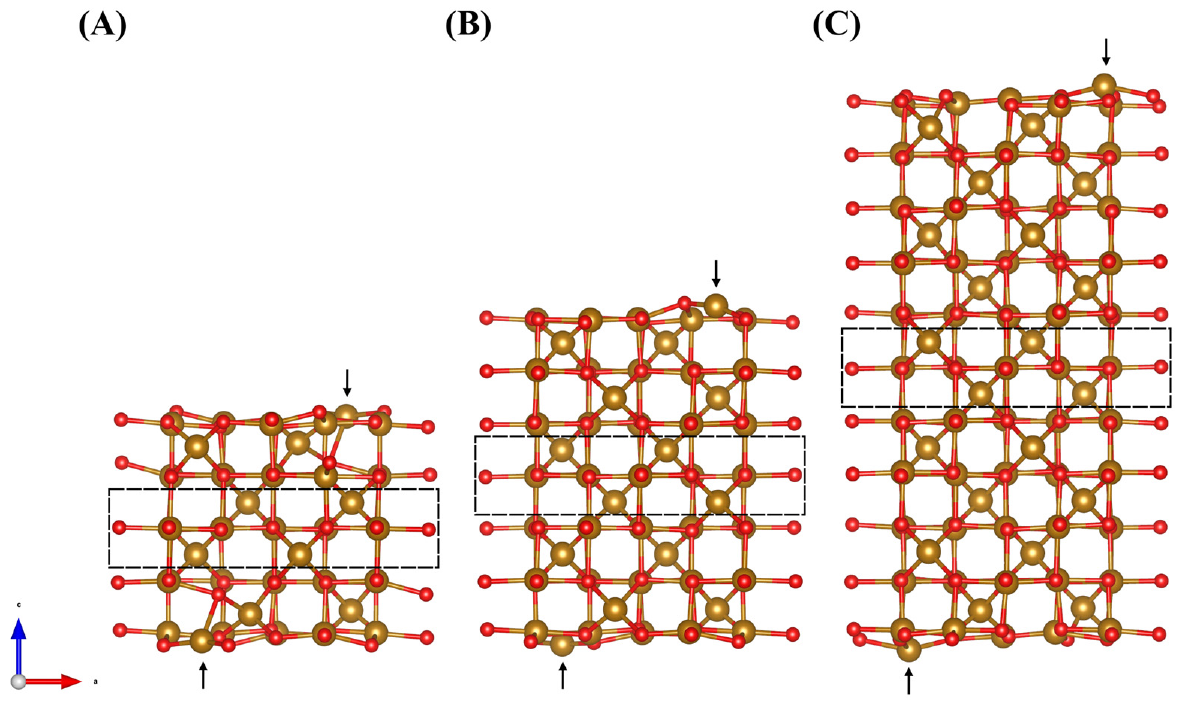
Figure 7. The 9-layer ( A ), 15-layer ( B ), and 23-layer ( C ) relaxed surfaces with Hubbard U correction. Dashed rectangle indicates region where atoms within are constrained to their relaxed bulk positions. The arrows point at Fe tet atoms in the first surface termination layer.